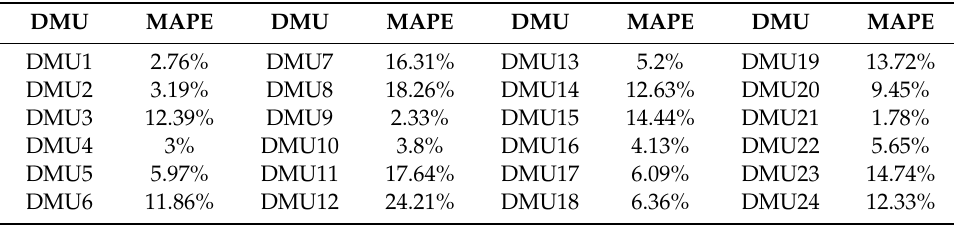
Table 4. Average MAPE of all